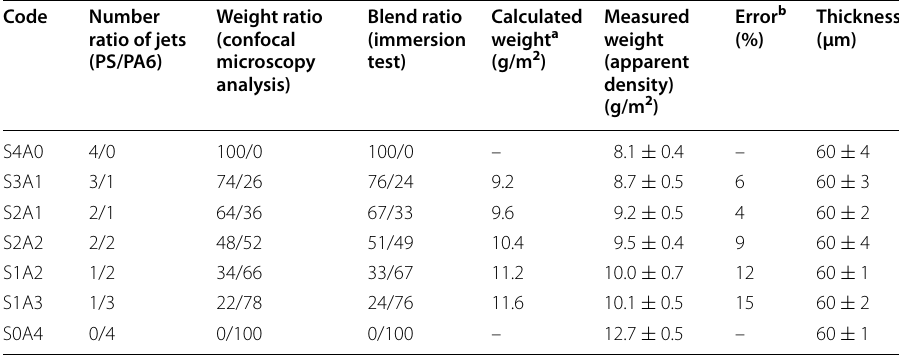
Table 1 Characteristics of the electropsun webs